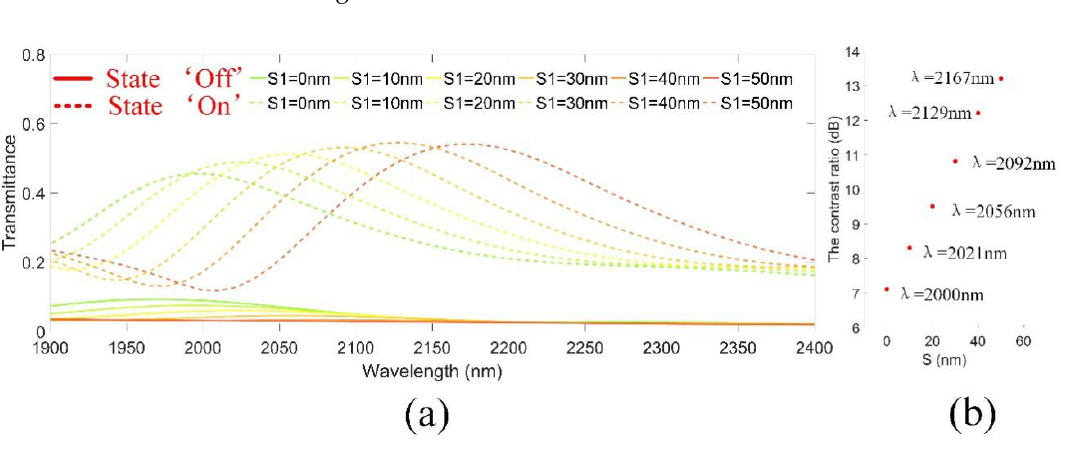
Figure 4. ( a ) Transmittance spectrum of changing the tip length S 1 in U-shaped structure; ( b ) The contrast ratio and working wavelength of plasmonic optical switch under different length S 1 .